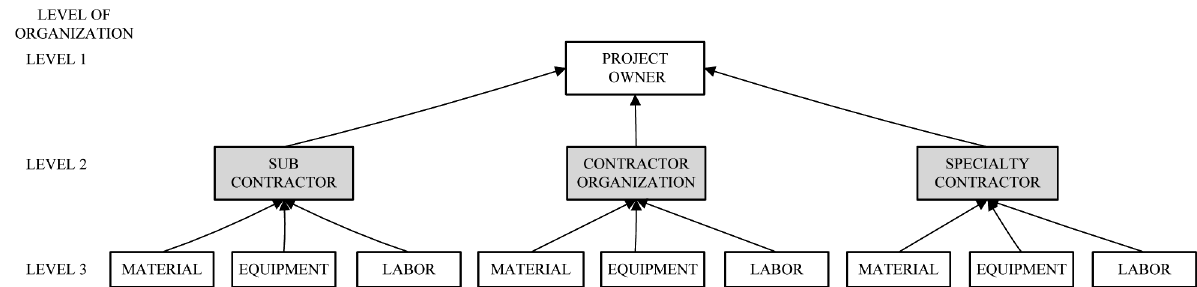
Fig. 2. Distinctive pattern Type 1 of construction supply chains (Susilawati 2005)